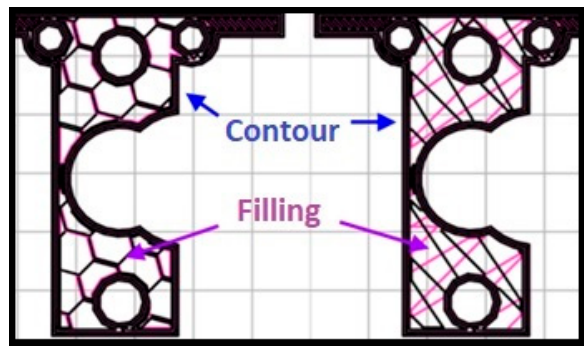
Figure 1. Section of a piece printed with two types of fill patterns. Left: honeycomb, right: linear.